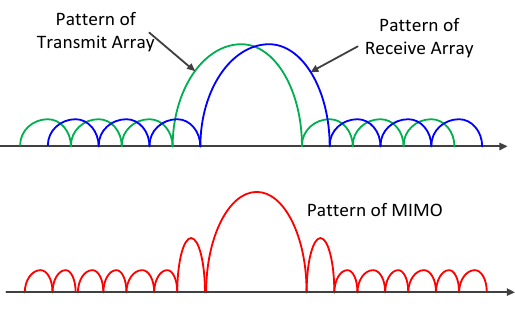
Figure 7. Influence of peaks’ offset of T/R patterns.